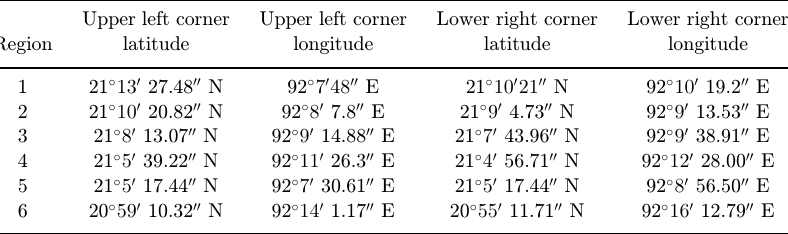
Table 3. Co-ordinates of upper left and lower right corners of regions of study area. Upper left corner Upper left corner Lower right corner Lower right corner Region latitude longitude latitude